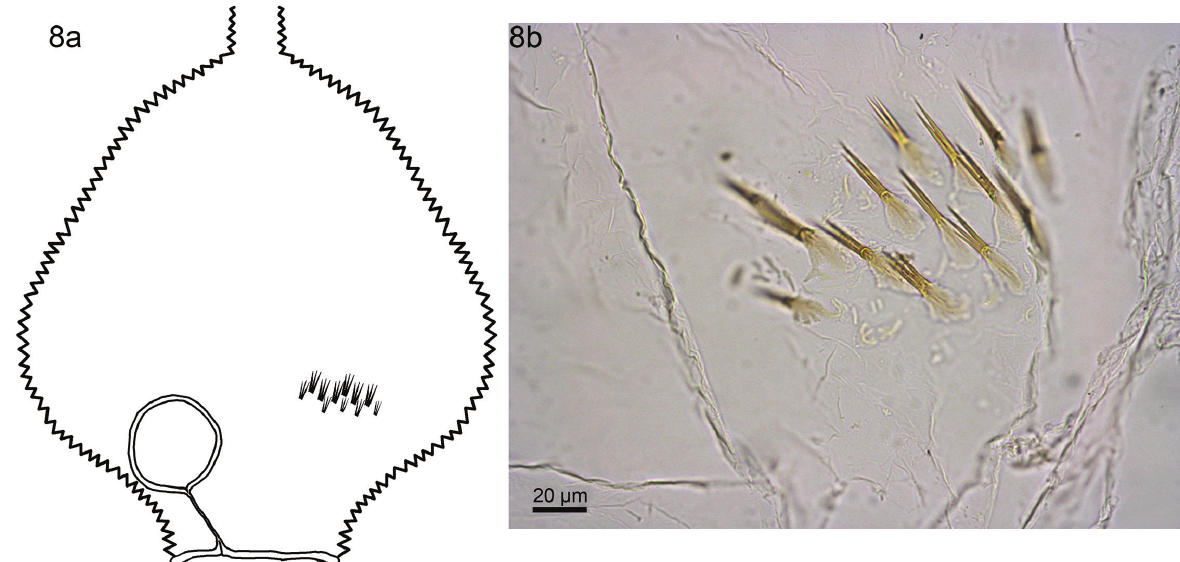
Figure 8. Embiratermes ignotus . (a) Schematic drawing of P1 showing arrangement of spines; (b) Photomicrograph showing detail of trifurcated